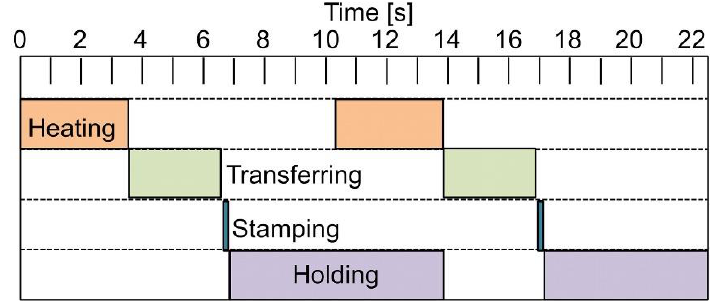
Figure 2. Time table of hot stamping having simultaneous heating of next blank with the die quenching.